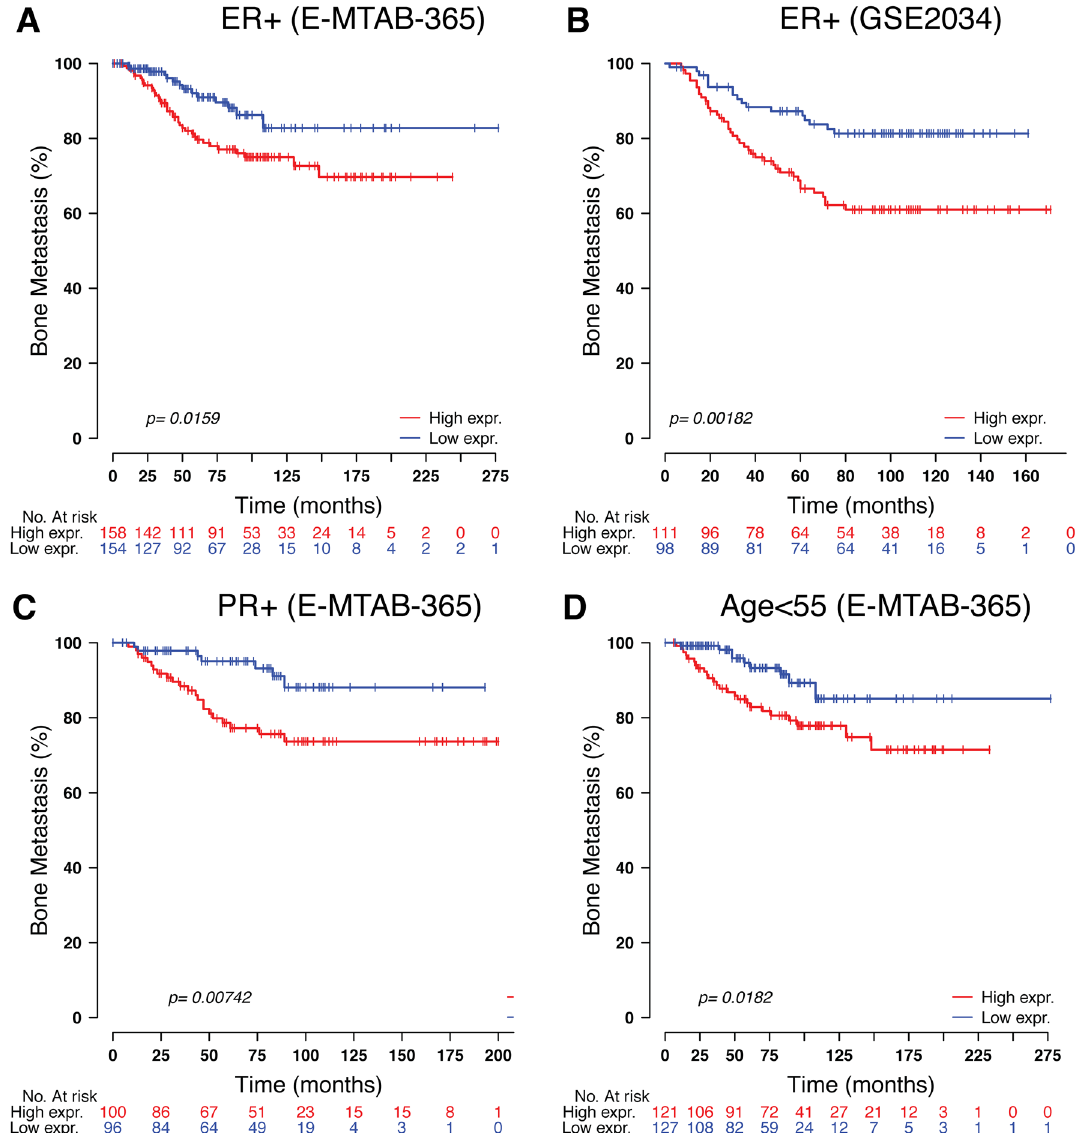
Figure 5. Significant association of TOR1B expression molecular markers and clinical information. Kaplan ‒ Meier curve based on the expression of TOR1B in ER-positive breast cancer patients from the E-MTAB-356 ( A ) and GSE2034 ( B ) datasets, PR-positive breast cancer patients ( C ) and patients aged more than 55 years ( D ) from the E-MTAB-356 dataset. Middle-aged groups of patients. The p value was calculated by log-rank